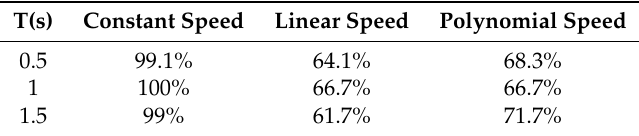
Table 4. Accuracy of the SVM with respect to the length of the signal.